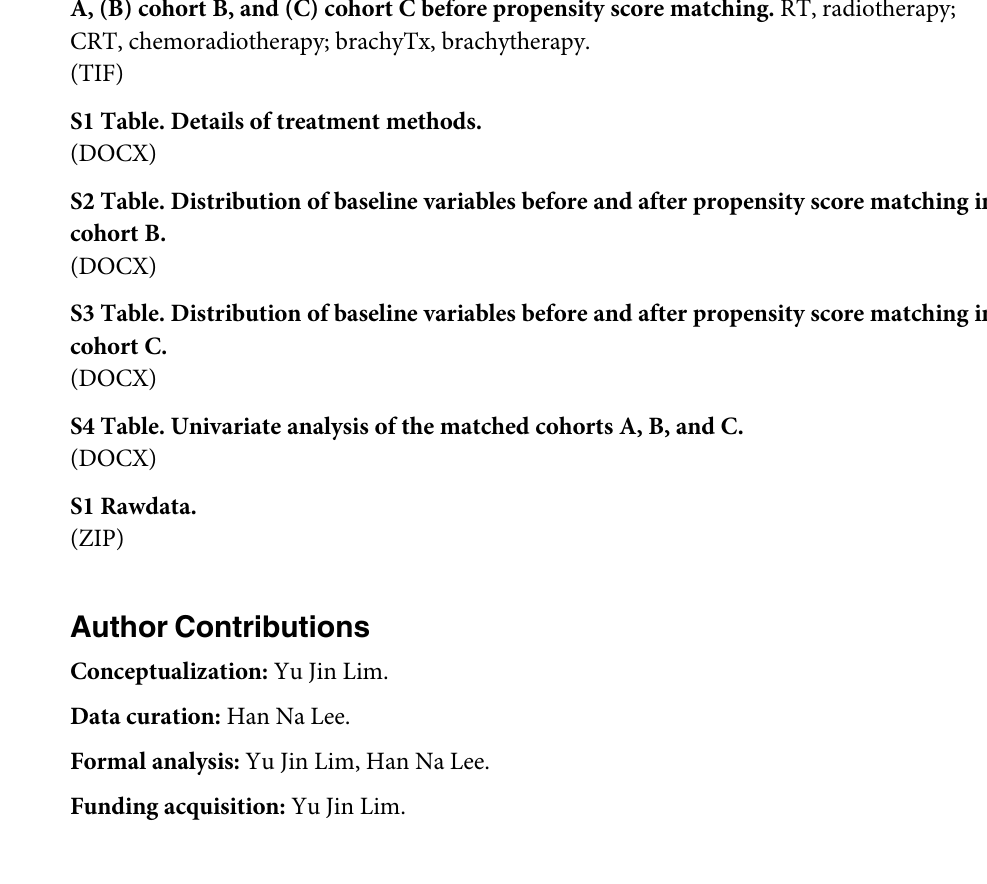
S1 Fig. Flowchart of the patient selection process. FIGO, International Federation of Gyne- cology and Obstetrics. S2 Fig. Changes in the rates of (A) irradiation methods and (B) use of chemotherapy over time in the primary radiotherapy group. S3 Fig. Overall survival according to hysterectomy and primary radiotherapy of (A) cohort A, (B) cohort B, and (C) cohort C before propensity score matching. RT, radiotherapy;